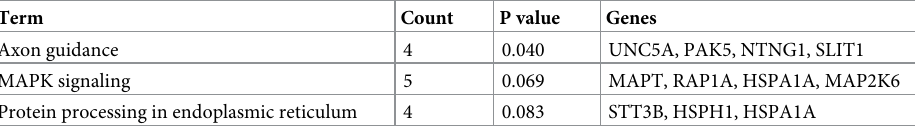
Table 2. DAVID pathways for main effect of